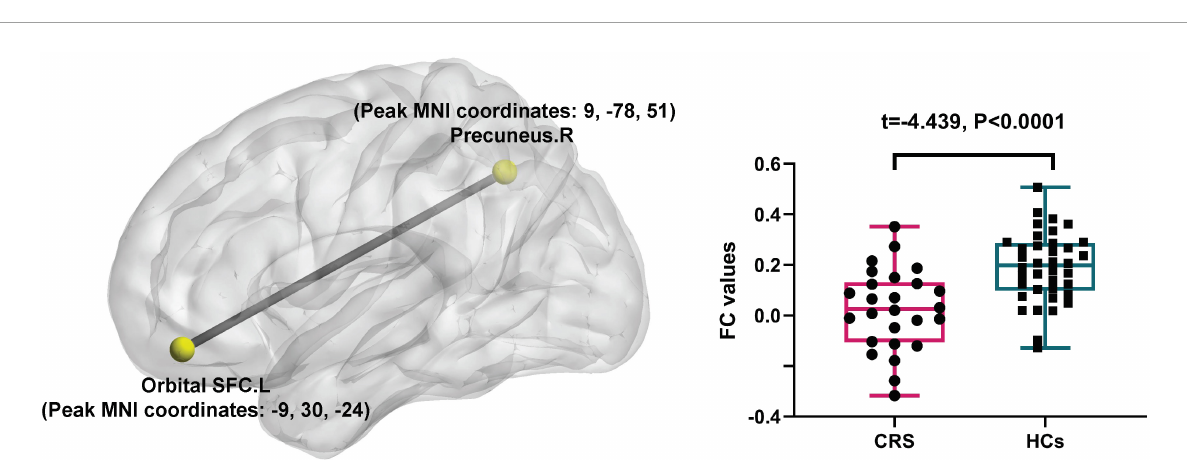
root of the power spectrum was computed, and the averaged square root was obtained across 0.01-0.08 Hz to acquire the ALFF. Eventually, to minimize the global influence, the ALFF values were divided by the global mean ALFF values for standardization. Based on the findings of ALFF, the abnormal